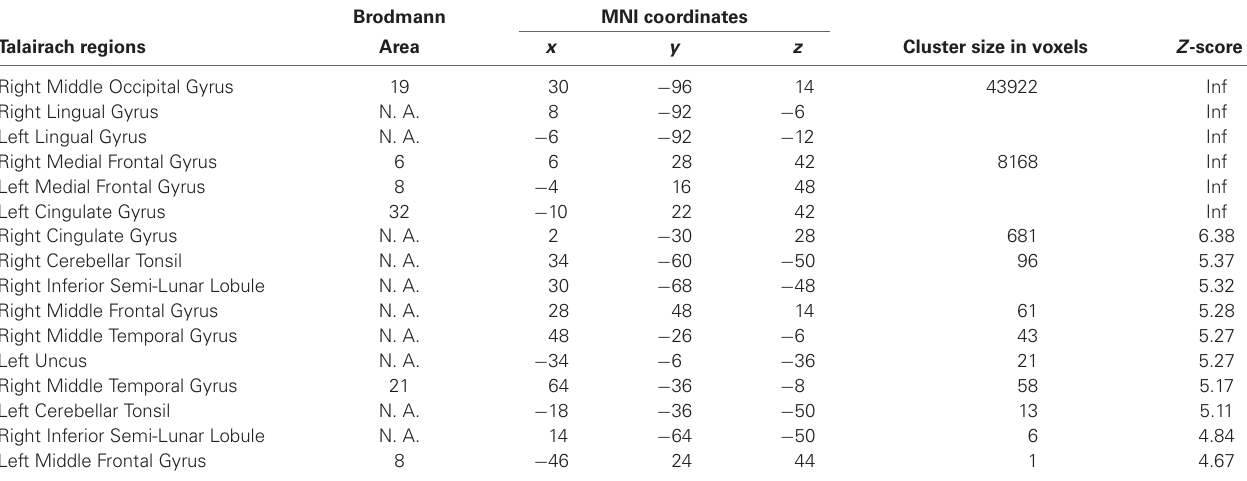
Table 1 | Brain regions and coordinates of clusters and local maxima for aesthetic appreciation of paintings . Brodmann MNI coordinates Talairach regions Area Right Middle Occipital